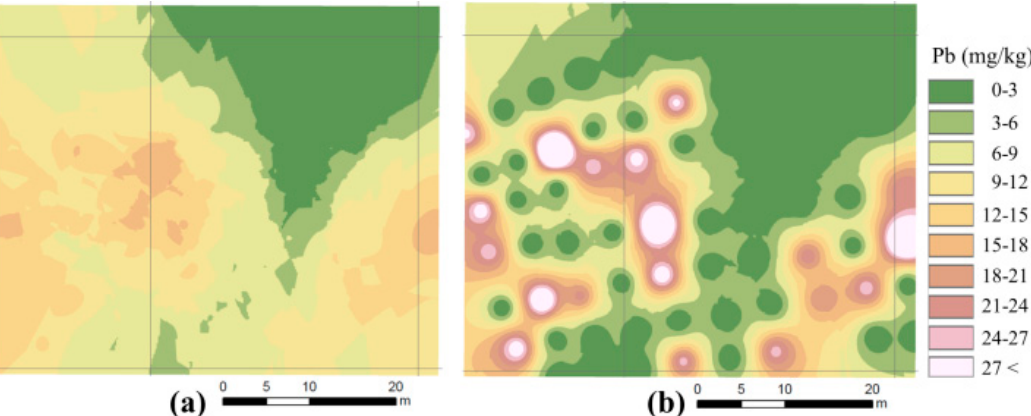
Figure 5. Sand contamination map of Pb. ( a ) Kriging result and ( b ) inverse distance weighting (IDW) result.